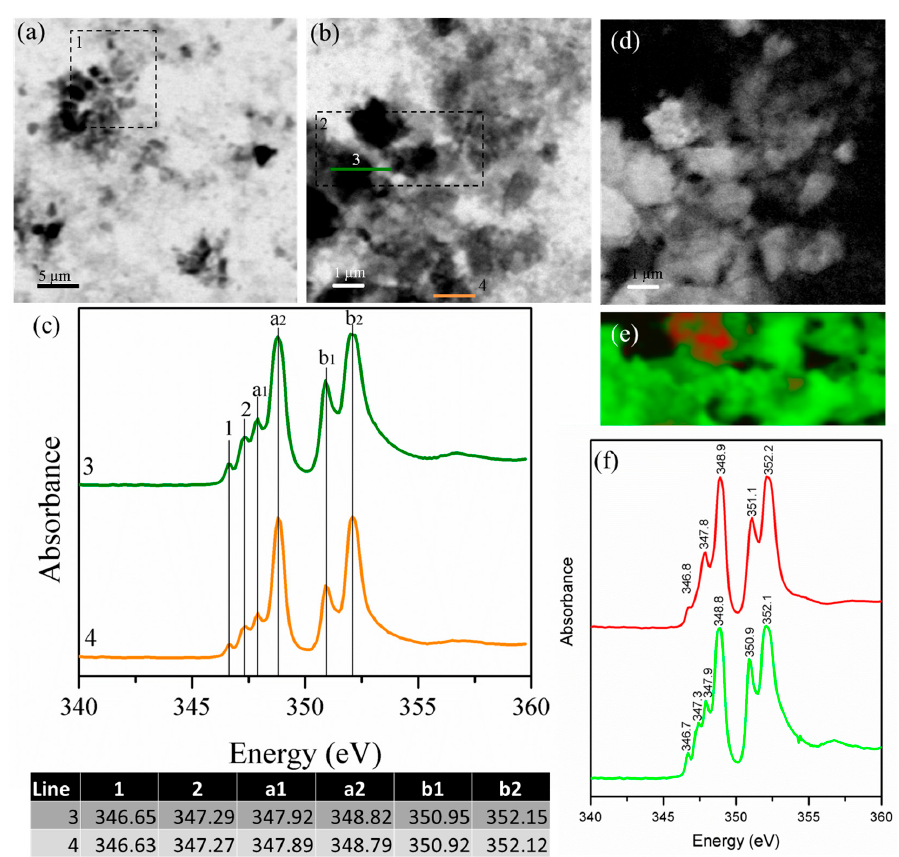
Figure 6. ( a ) Image taken at the calcium L II,III edge of the gypsum/cubic-C 3 A blends at a ratio of 0.20 after three days of curing; ( b ) magnification of area 1 in image ( a ); ( c ) NEXAFS spectra of the line scans indicated in ( b ); ( d ) image maps of calcium in the same area as ( b ), where the brighter areas are related to higher concentrations of calcium; ( e ) Red-green-blue (RGB) composite map of region 2 in image ( b ) (red area is related to ettringite and the green area corresponds to the monosulfate phase); and ( f ) NEXAFS spectra of the red and green regions observed in image ( e ).